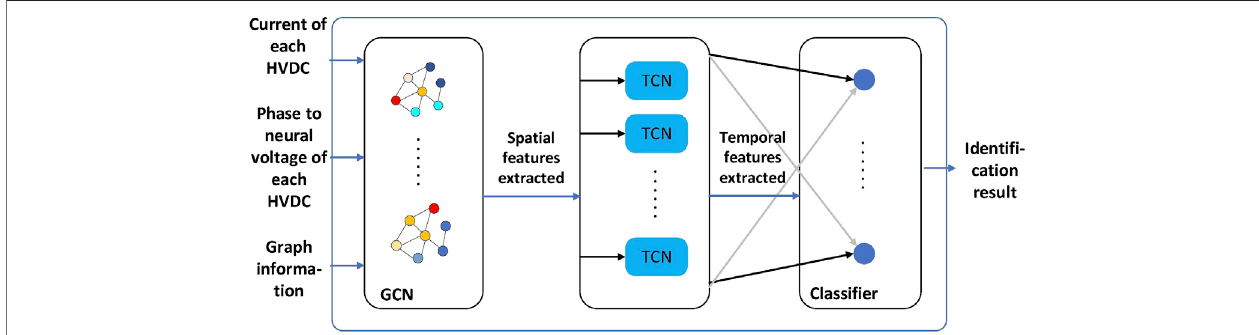
FIGURE 3 | Structure of STCN for identifying cascading commutation failures.